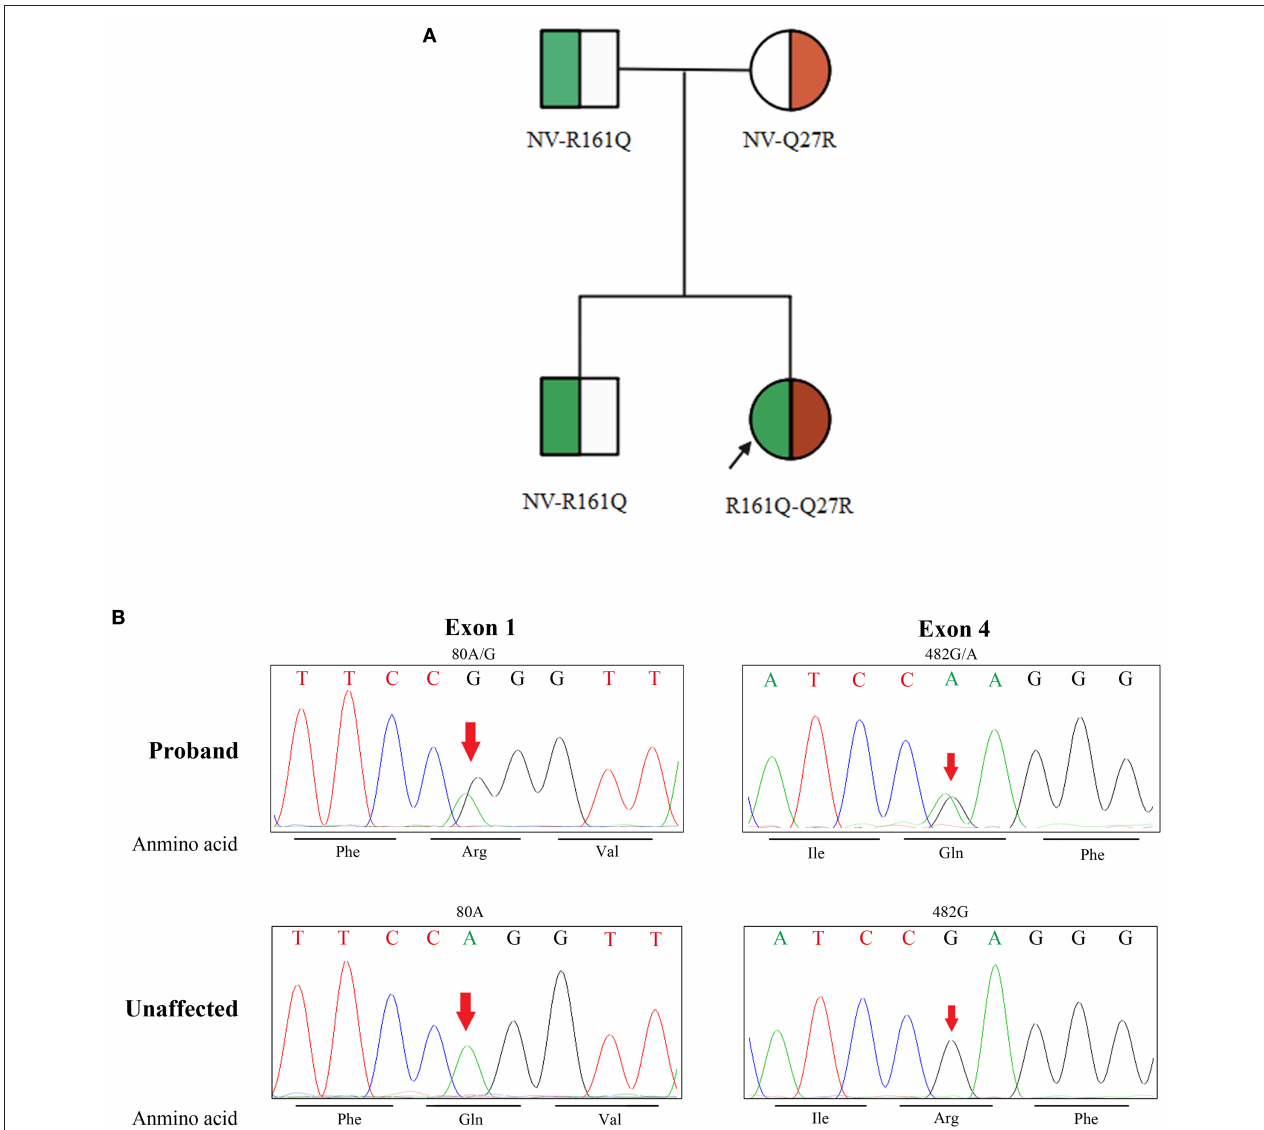
FIGURE 3 | Family pedigree and identification of MMACHC mutation. (A) Shows the family pedigree. Squares indicate male family members, and circles represent female family members. The arrow indicates the proband. The symbol of both green and red in the circle represent heterozygote. NV, non-variant. (B) Shows the mutated locus of the DNA sequences. Phe, phenylalanine; Arg, arginine; Val, valine; Ile, isoleucine; Gln, glutamine; Unaffected, unaffected family